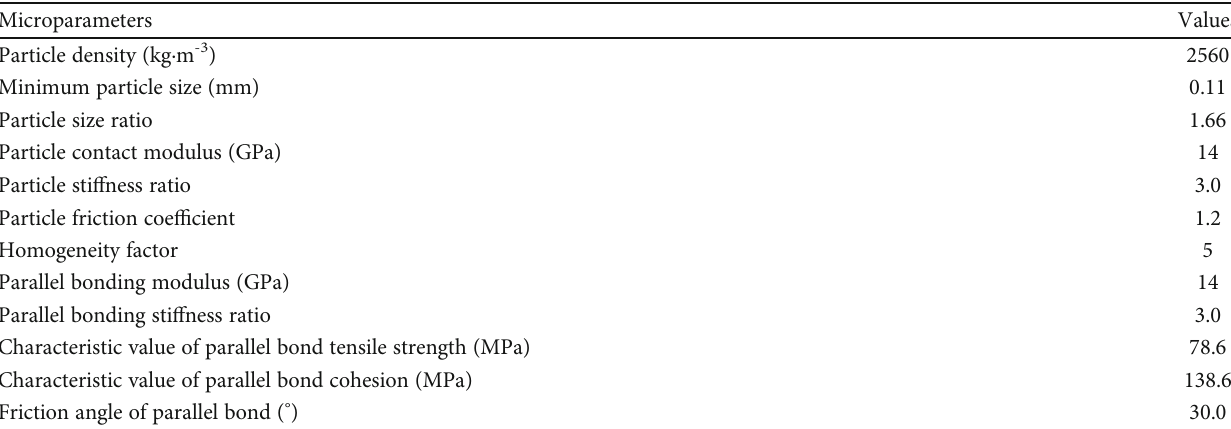
Figure 4: The density distribution of the parallel bond tensile strength ( (cid:1) λ = 78 : 6MPa, m = 5 ). Table 1: The microparameters used in the PFC 2D